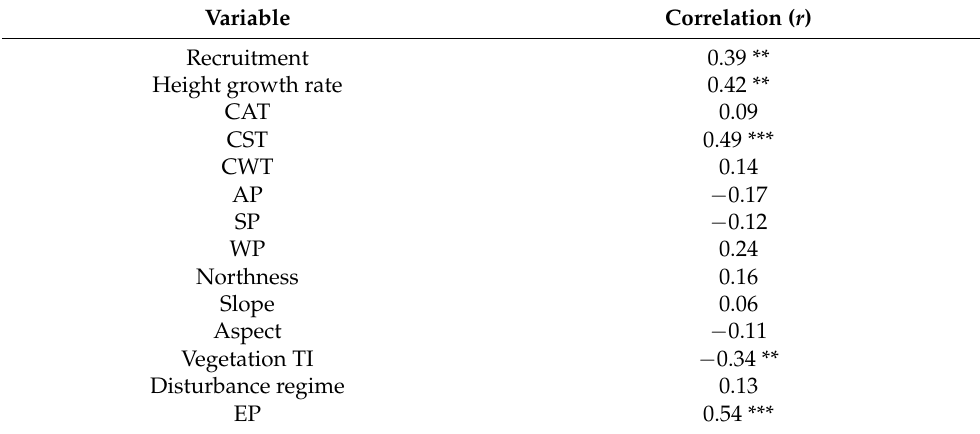
− 0.11 Vegetation TI − 0.34 ** Disturbance regime 0.13 0.54 *** Table 2. Partial correlations between predictor variables and treeline shifts. The potential predictor variables included changes in annual, summer and winter mean minimum temperature (i.e., CAT, CWT and CST) and annual, summer and winter precipitation (i.e., AP, SP and WP) over the last century; height growth rate (HGR), tree recruitment (RE), vegetation TI (TI) and expansion potential (EP). Partial correlation significance: * p < 0.05; ** p < 0.01; *** p < 0.001. Variables Partial Correlations with Treeline Shifts Controlled Variables CST CAT, CWT − 0.10 CST, CWT − 0.08